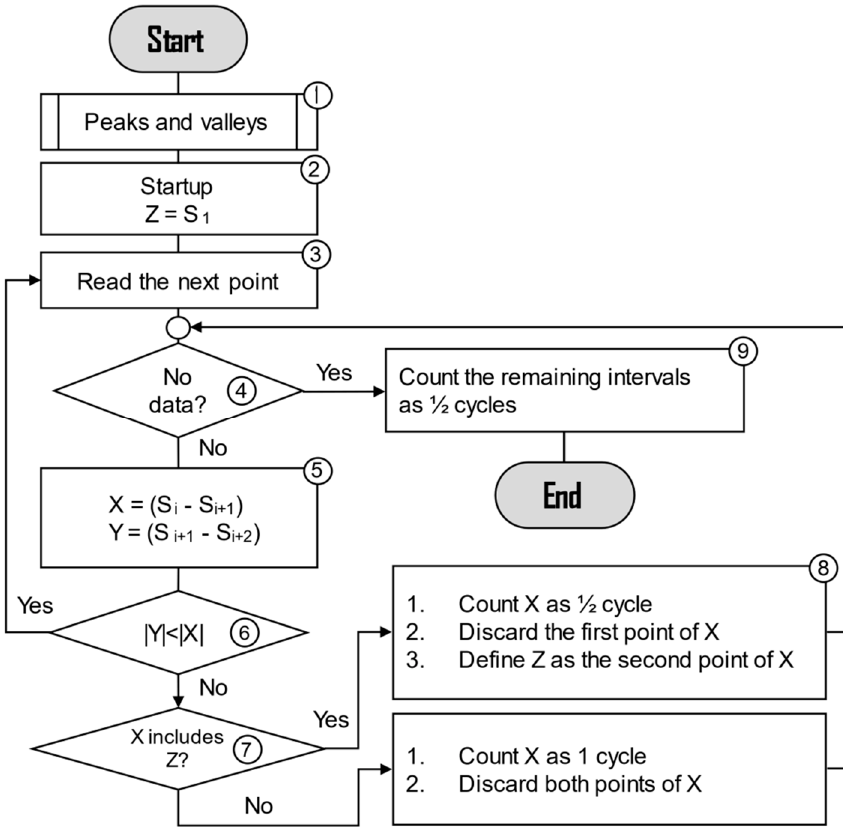
Figure 1. Rainflow counting algorithm.